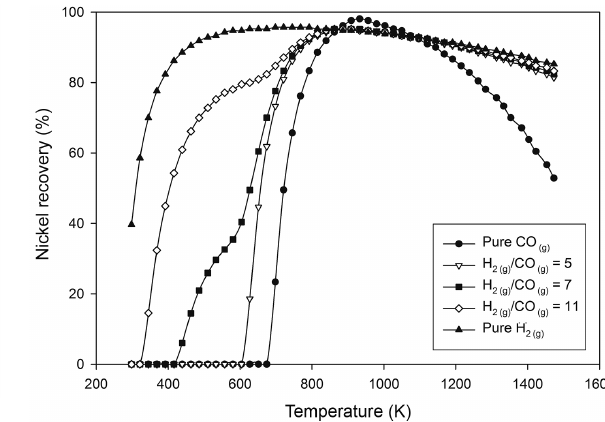
Figure 13: Effect of temperature on the composition of the gas phase ferronickel alloy for reduction of the calcined ore in pure carbon Figure 14: Effect of temperature on the nickel recovery for reduction monoxide or pure hydrogen at a reductant to ore ratio of 0.558 kmol/ of the calcined ore in pure carbon monoxide, pure hydrogen and 100 kg. Also included are the log P O values for carbon monoxide and various hydrogen to carbon monoxide ratios at a reductant to ore 2 hydrogen. ratio of 0.558 kmol/100